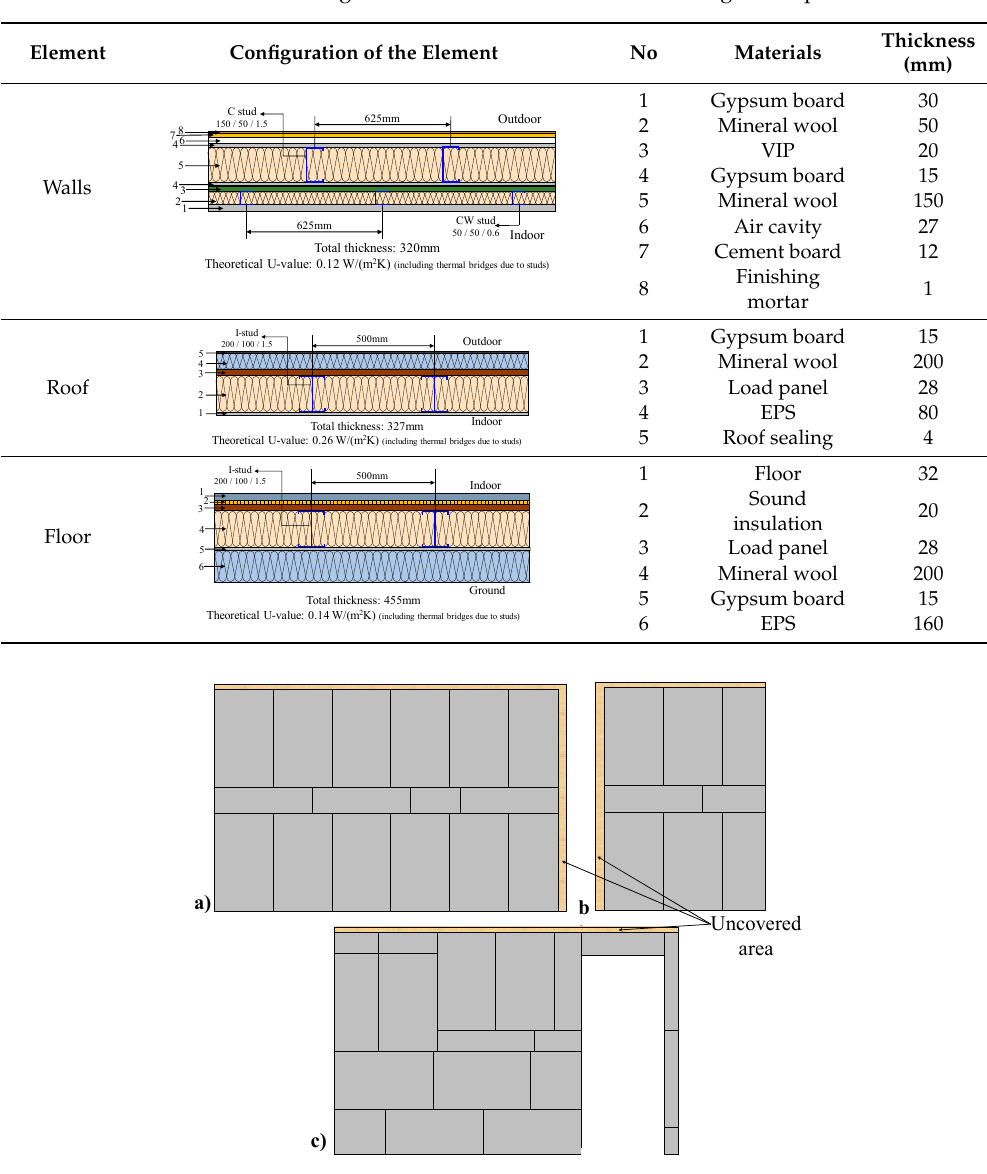
Figure 2. Pattern of the vacuum insulation panels (VIP) for ( a ) the north, ( b ) the east and west, and ( c ) the south wall.